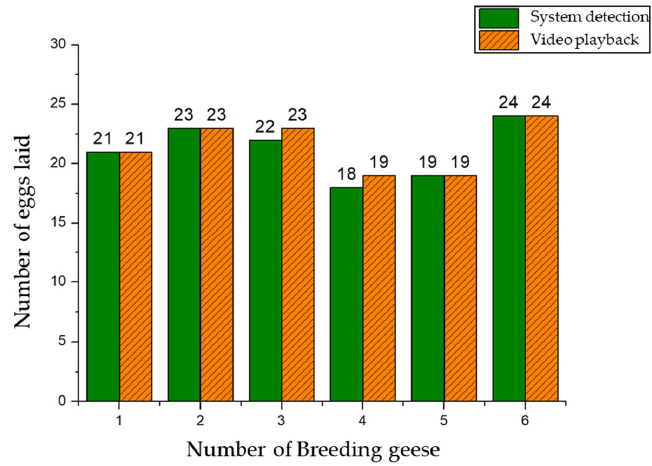
Figure 11. Comparison of egg production in different recording